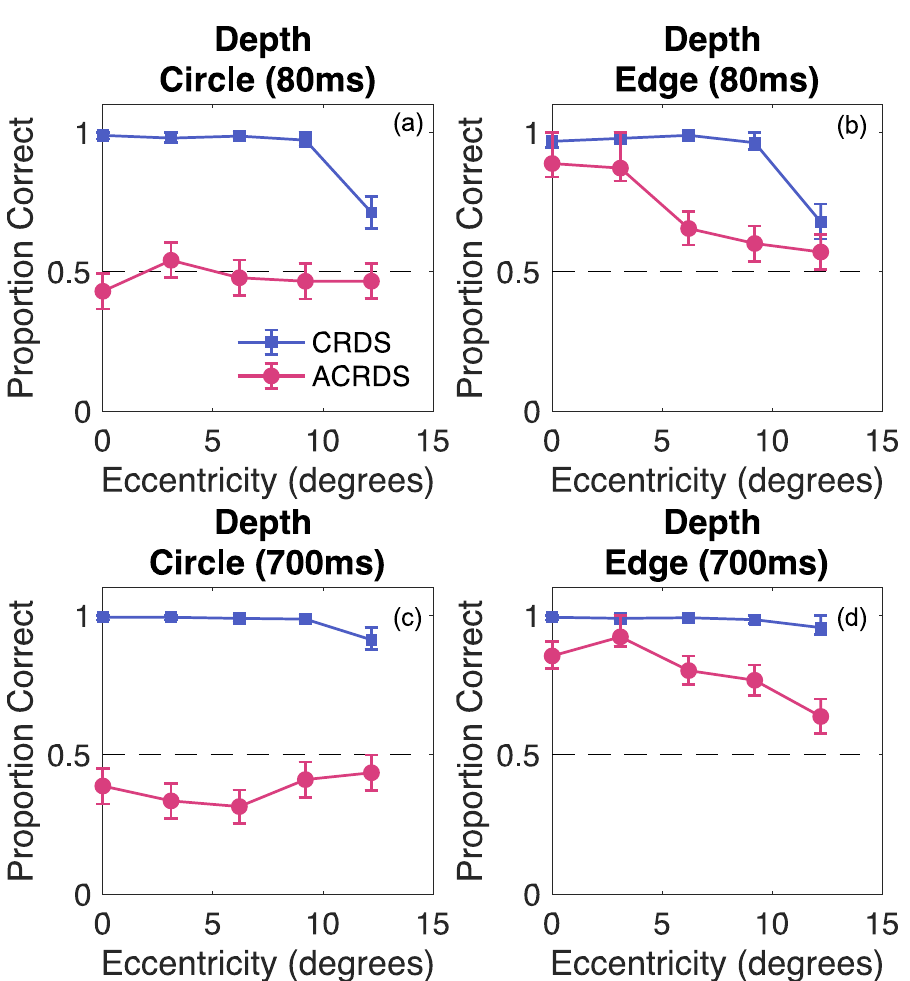
Fig 5. Proportion of correct depth responses as a function of eccentricity. The top row plots data for the short duration (80ms) for (a) circular and (b) horizontal edge stimuli. The bottom row plots data for the long duration (800ms) for (c) circular and (d) horizontal edge data. In all cases, the blue squares plot data for CRDS and the pink circles plot data for the ACRDS. Data show the mean results across participants, and bootstrapped 95 percent confidence limits. The horizontal dotted line shows chance performance. In all cases, depth was seen in the natural direction for CRDS. For the short duration ACRDS stimuli, there was no reliable perception of depth for the circular stimuli. Depth was perceived in the natural direction for edge stimuli, decreasing with eccentricity. For the long duration ACRDS stimuli, depth was seen in the reversed direction for circular stimuli, and in the natural direction for horizontal edge stimuli. For the edge stimuli, the reliability of perceived depth reduced with